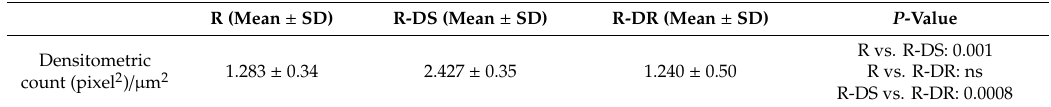
Figure 6. Lubricin immunohistochemical evaluation in the articular cartilage through computerised densitometric measurements and image analysis. ( A ) R group; ( B ) R-DS group; ( C ) R-DR group. In inserts are the image analyses by the software in which the red colour represents brown staining (immune complexes labelled with chromogen). For details, see the text. ( A – C ) Objective lens, 10; scale bars: 100 μ m. These are the most representative images of articular cartilage from rats of each group (R, R-DS and R-DR). Table 7. LUBRICIN Immunostaining—Articular cartilage.